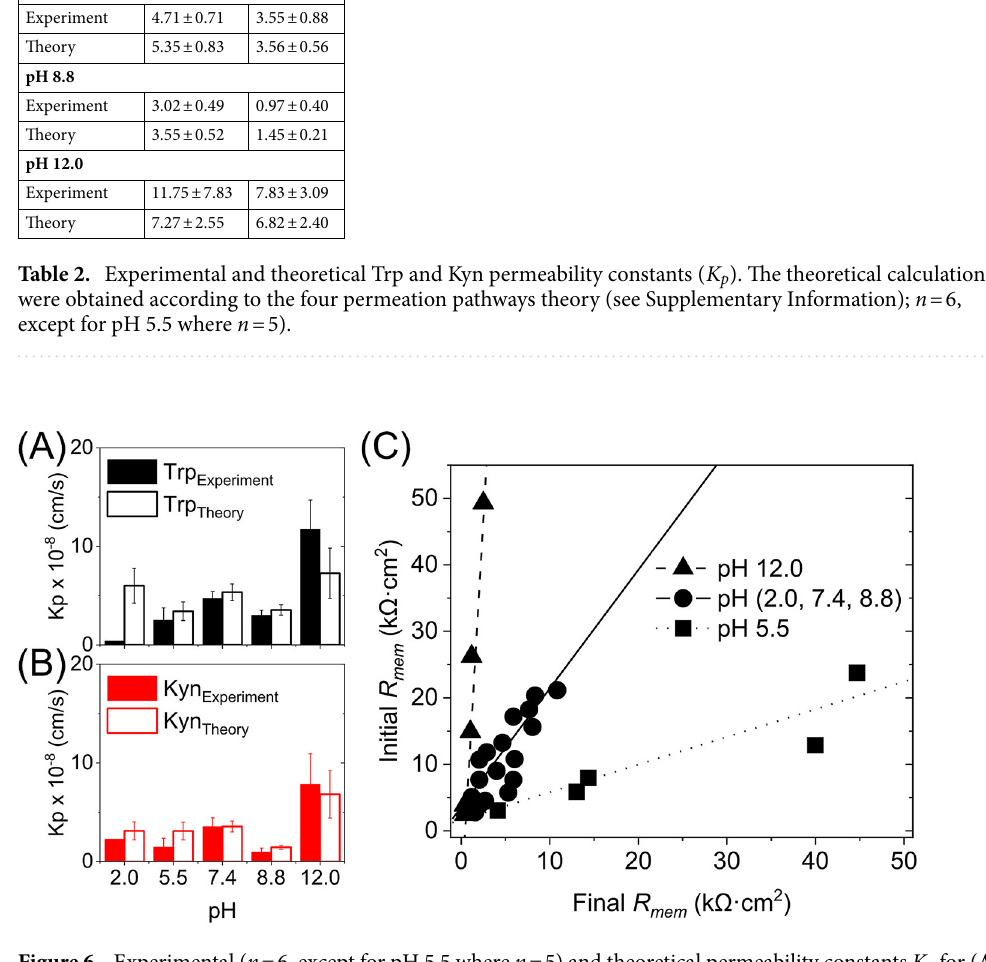
Figure 6. Experimental ( n = 6, except for pH 5.5 where n = 5) and theoretical permeability constants K p for ( A ) Trp and ( B ) Kyn as a function of pH. ( C ) Correlation between initial (0 h) and final (after 45 h) skin membrane resistance ( R mem ) for various pH values; n = 6 at pH 12, n = 18 at pH 2.0, 7.4, 8.8, n = 5 at pH